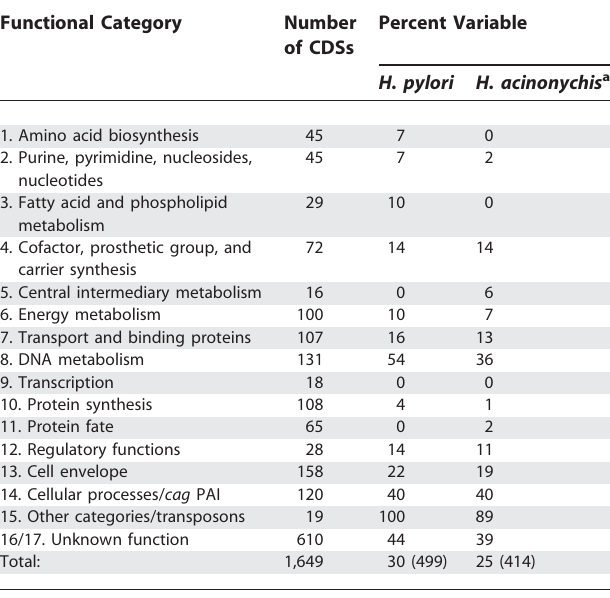
Table 1. Variable CDSs in H. pylori and H. acinonychis